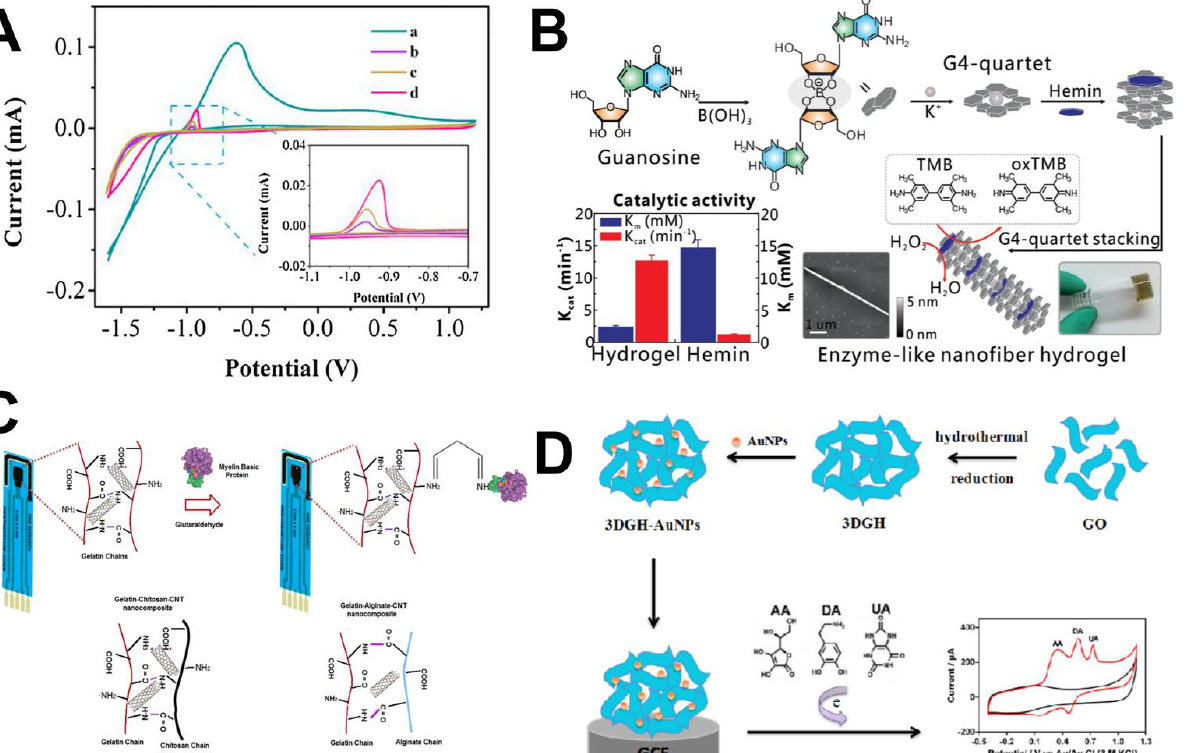
Figure 5. ( A ) CV scans of 2.5 Mm zinc ions in (a) an acetic acid-sodium hydroxide solution, (b) the chitosan hydrogel, (c) the chitosan hydrogel with 0.01 Mm H 2 O 2 and (d) the chitosan hydrogel with 0.03 Mm H 2 O 2 [70]. ( B ) Schematic diagram of forming enzyme-like nanofibrous hydrogel from guanosine and B(OH) 3 via formation of K + -templated G4 quarte [77]. ( C ) Formation of CNT-based hydrogel [82]. ( D ) Formation of 3D graphene—AuNPs hydrogel [83]. Copyright: Elsevier B.V. and John Wiley and